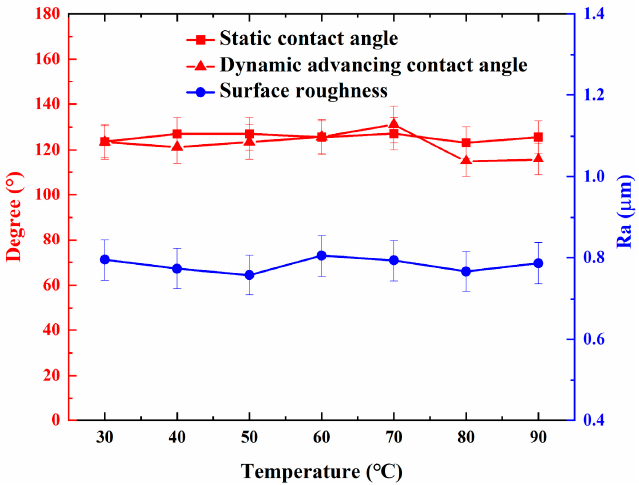
Figure 3. Static contact angle, dynamic advancing contact angle and surface roughness versus tem- perature for the PTFE membrane.